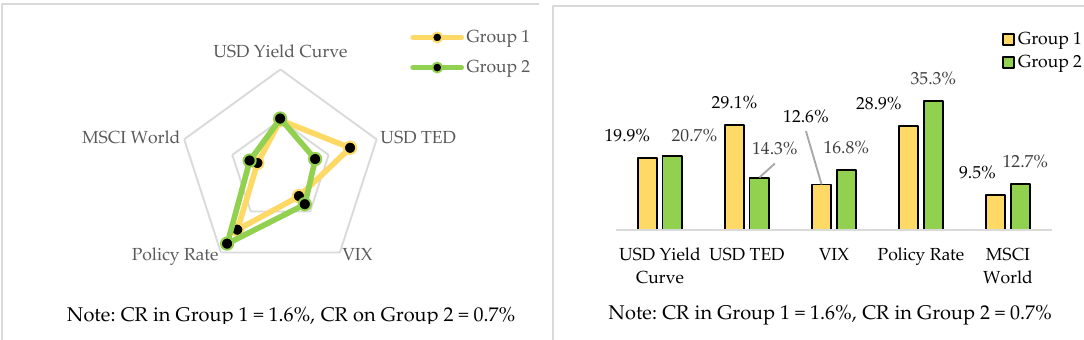
Figure 10. Local weights for international factors between group 1 and group 2.